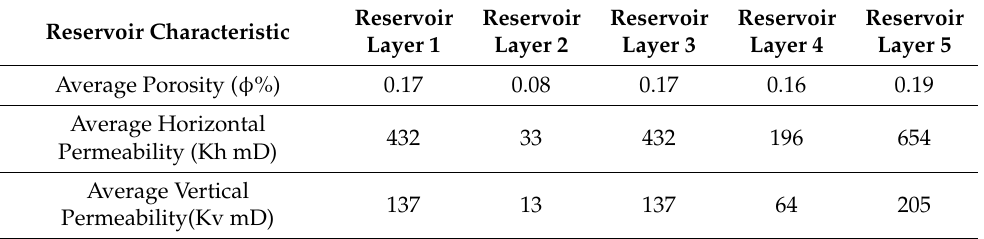
Table 1. PUNQ-S3 average of key parameters for each reservoir layer (Al-Mudhafar et al., 2021).